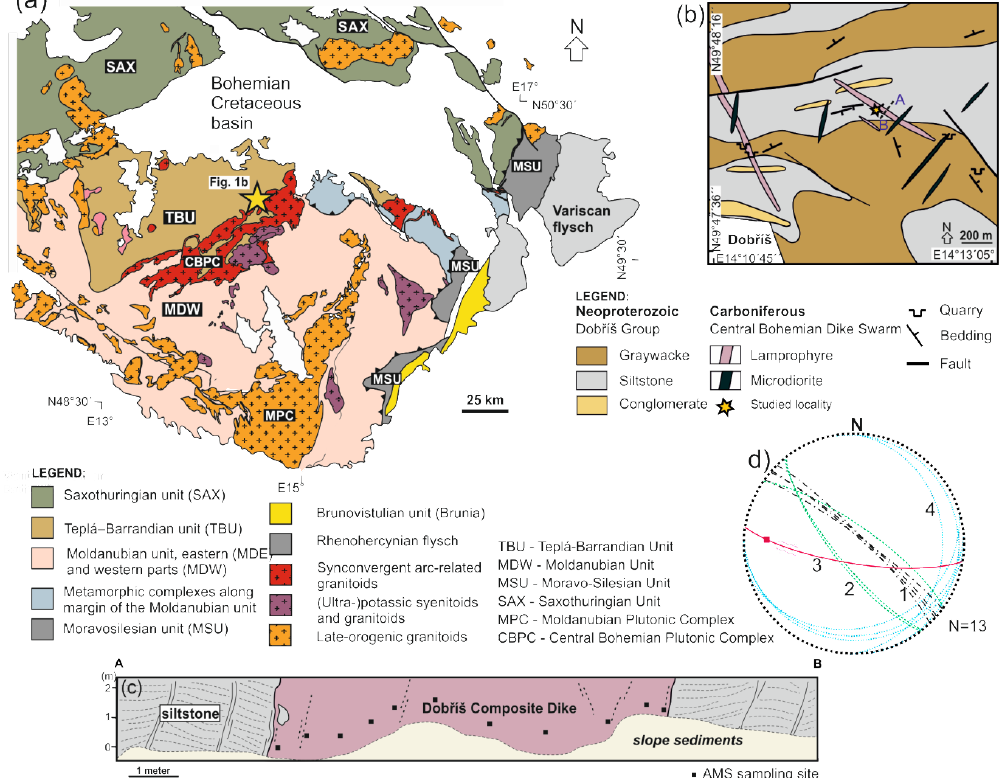
Figure 1. ( a ) Simplified geological map of the Bohemian Massif ( b ) detailed situation of the dyke near Dobříš. ( c ) Field scheme of NE – SW cross-section with schematic locations of samples for anisotropy of magnetic susceptibility (AMS) and petrological analysis. ( d ) Orientations of mesoscopic structural elements (equal area projection to lower hemisphere): intrusive contacts (1), cleavage (2), fault plane (slickensides) (3), bedding (4), The map (a) is compiled using [30]. In the Moldanubian Zone, magmatic rocks of Variscan age can be classified into four groups.